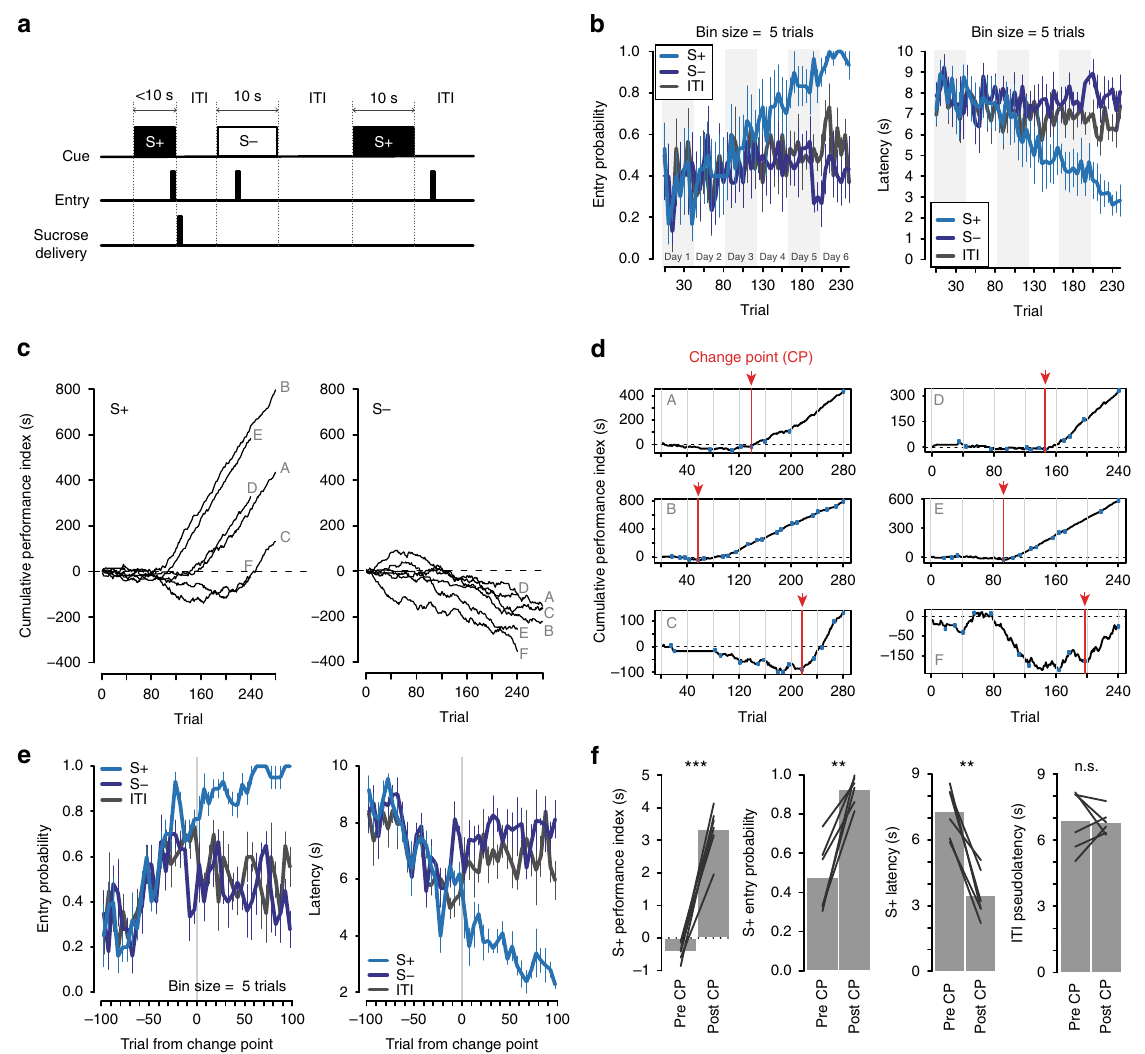
Fig. 1 With training, a detectable transition between exploratory and cued behavior occurs. a Task diagram. Only receptacle entries during the S + were rewarded. S + and S − trials were randomly interleaved. ITI: intertrial interval. b Average group entry probability (left) and latency (right) during three task periods: S + (light blue), S − (dark blue), and the ITI (gray) throughout training in 5-trial bins. Data are expressed as mean ± SEM. c Cumulative performance index records on S + (left) and S − (right) trials (see Methods and Supplementary Fig. 1 for an explanation of this index). Each animal ’ s behavior is represented by a black line and labeled with a gray letter. d Identi fi cation of the trial in which the consistent change in behavior took place (see Methods and Supplementary Fig. 2). The black line on each panel is the cumulative record of the performance index of each individual animal. Small blue dots mark the abrupt changes in the slope of the line detected by the algorithm. The vertical red line marks the change point (CP). Vertical gray lines indicate the transition between sessions. e Same as in b , but with trials aligned to the CP trial. f Comparison of average S + performance index (*** p < 0.001, t test), entry probability (** p < 0.01, t test), latency (** p < 0.01, t test) and ITI pseudolatency ( p = 0.86, t test) before vs. after change point; n.s. not signi fi cant. Details of all statistical tests are in Supplementary Table